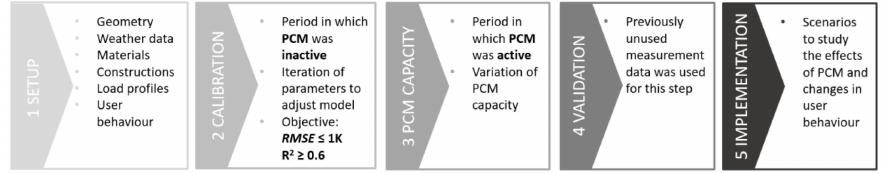
Figure 1. Process of model creation, PCM capacity determination and model